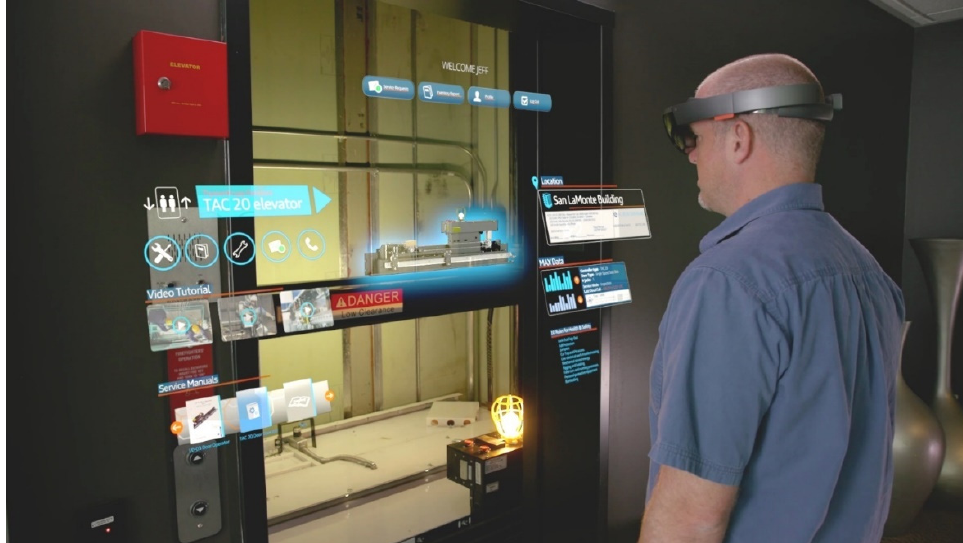
Figure 8. ThyssenKrupp MR solution for elevator maintenance.